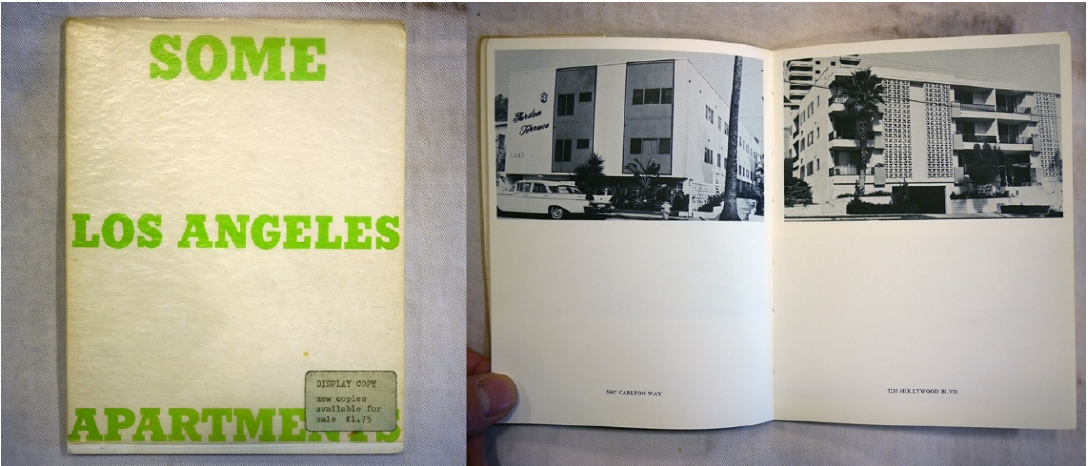
Figure 3. Edward Ruscha, Some Los Angeles Apartments , 1965. Courtesy of Arnolfini and Bristol Archives.